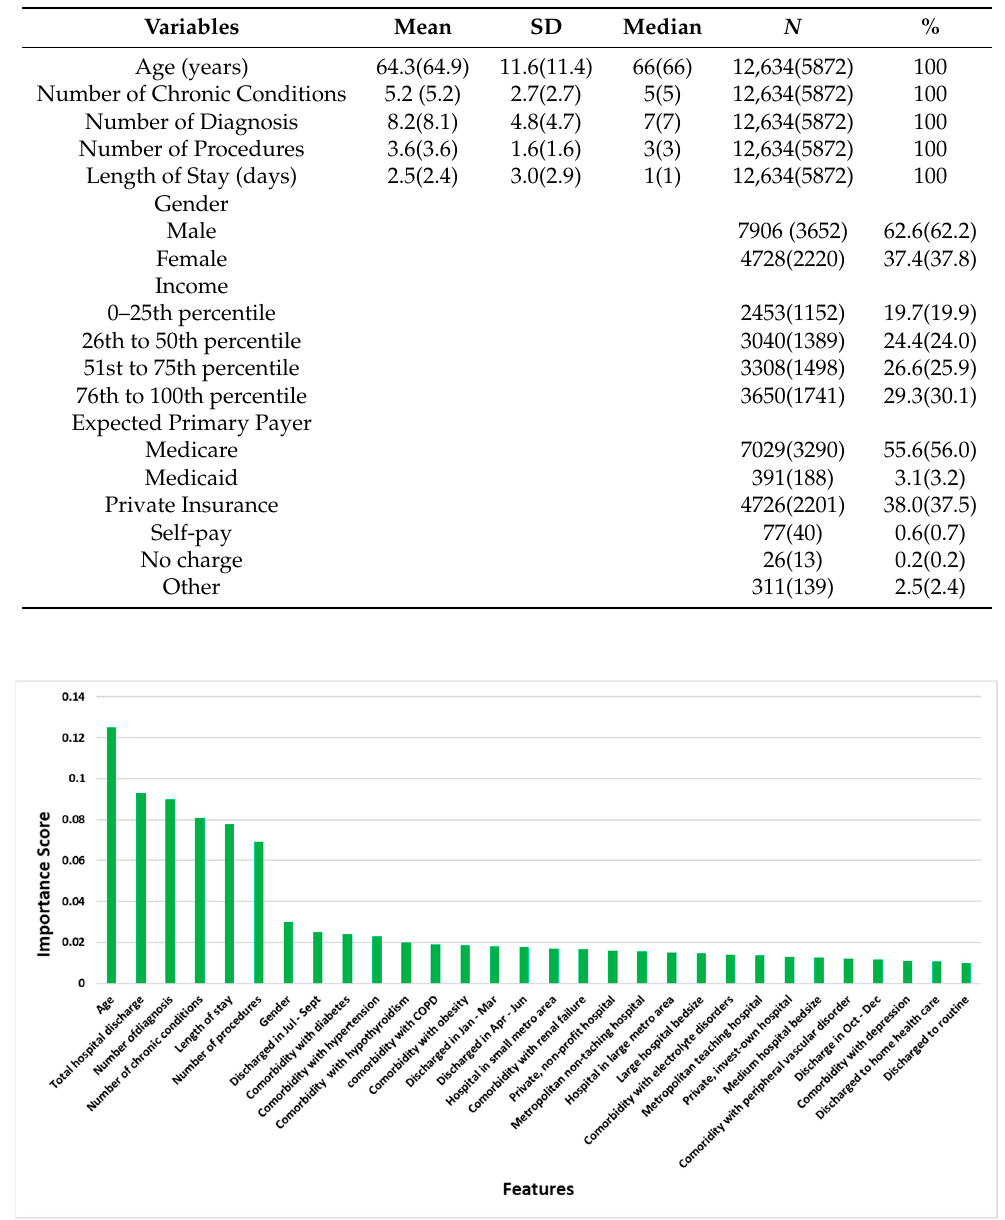
Table 2. Demographic characteristics of 30-day Readmissions (Ninside of parenthesis is unweighted).